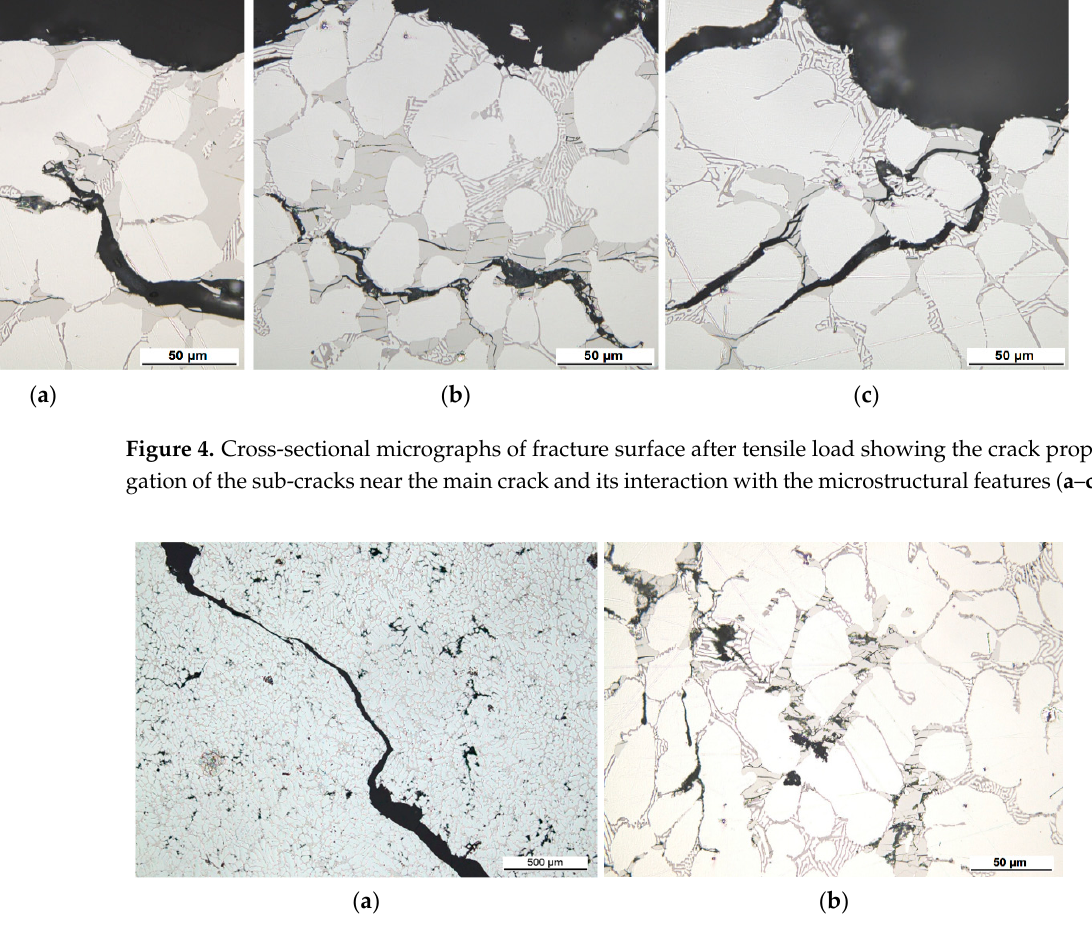
( d ) ( e ) Figure 6. Cross-sectional micrographs of fracture surface after fatigue load (R = 0, 43,000 cycles) showing the crack propagation of the sub-cracks near the main crack and its interaction with the microstructural features ( a – e ).